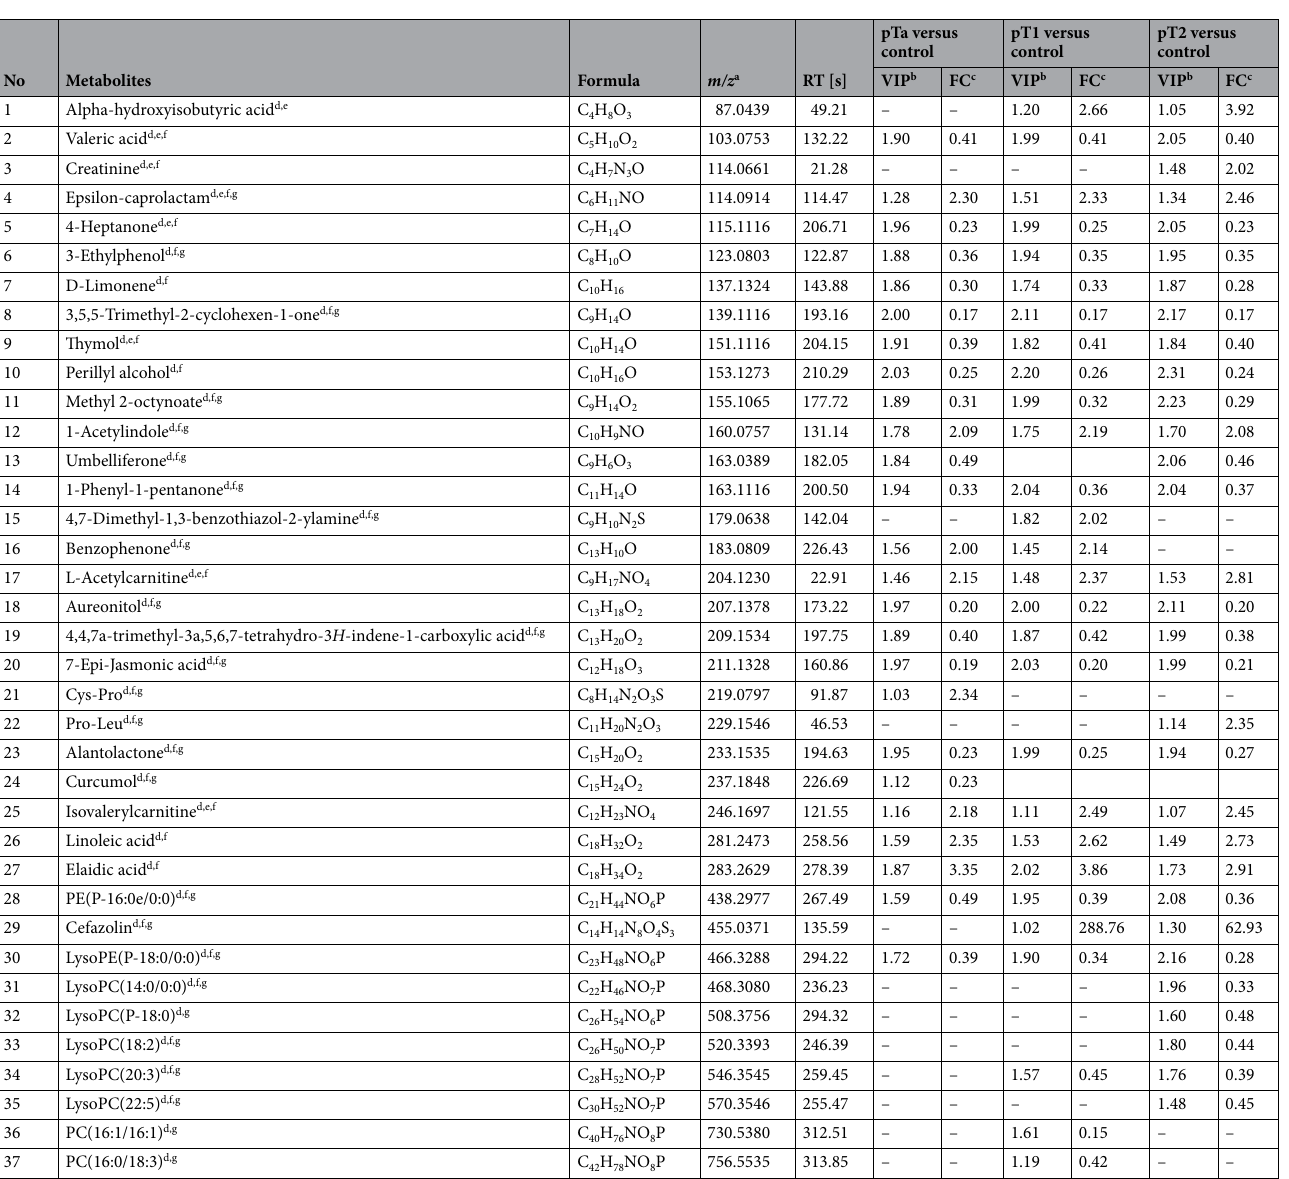
Table 3. Differential metabolites for discrimination between pTa, pT1 and pT2 BC patients and NCs ( p value < 0.05; FDR < 0.05; VIP > 1; FC < 0.5 and > 2). a Experimental monoisotopic mass; b VIP scores derived from OPLS-DA model; c fold change between cancer and control serum calculated from the abundance mean values for each group—cancer-to-normal ratio; d the metabolites identified by high precursor mass accuracy; e the metabolites identified by matching retention time; f the metabolites identified by matching isotopic pattern; g the metabolites identified by matching MS/MS fragment spectra; AUC: area under the curve; FC: fold change; FDR: false discovery rate; m/z : mass-to-charge ratio; pT1 and pTa—high risk non-muscle invasive bladder cancer; pT2—muscle invasive bladder cancer; RT: retention time; VIP: variable influence on